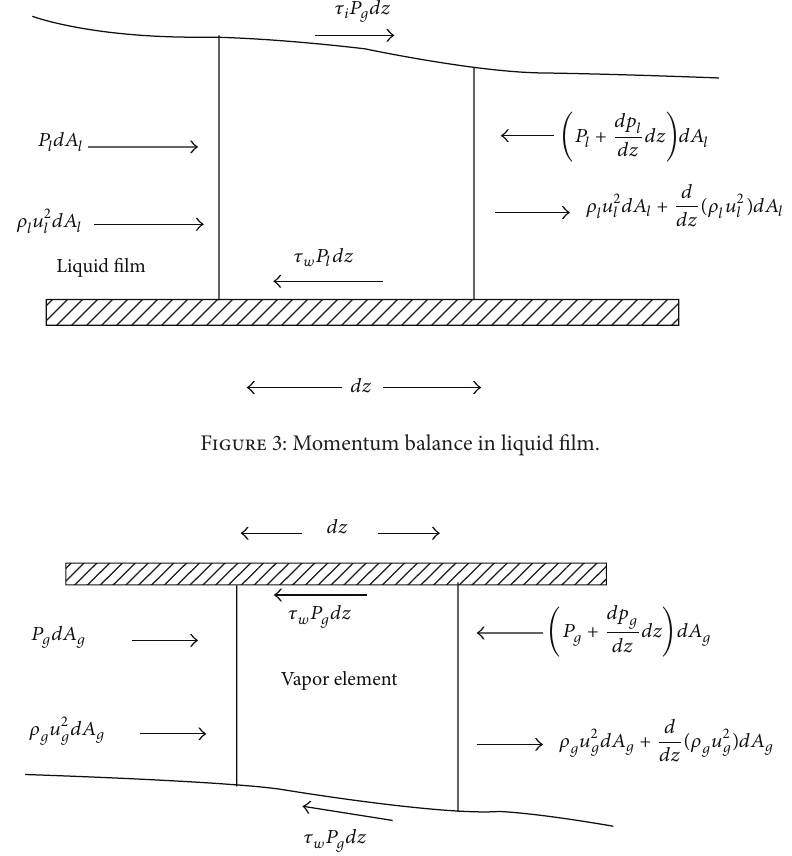
Figure 4: Momentum balance in vapor element.